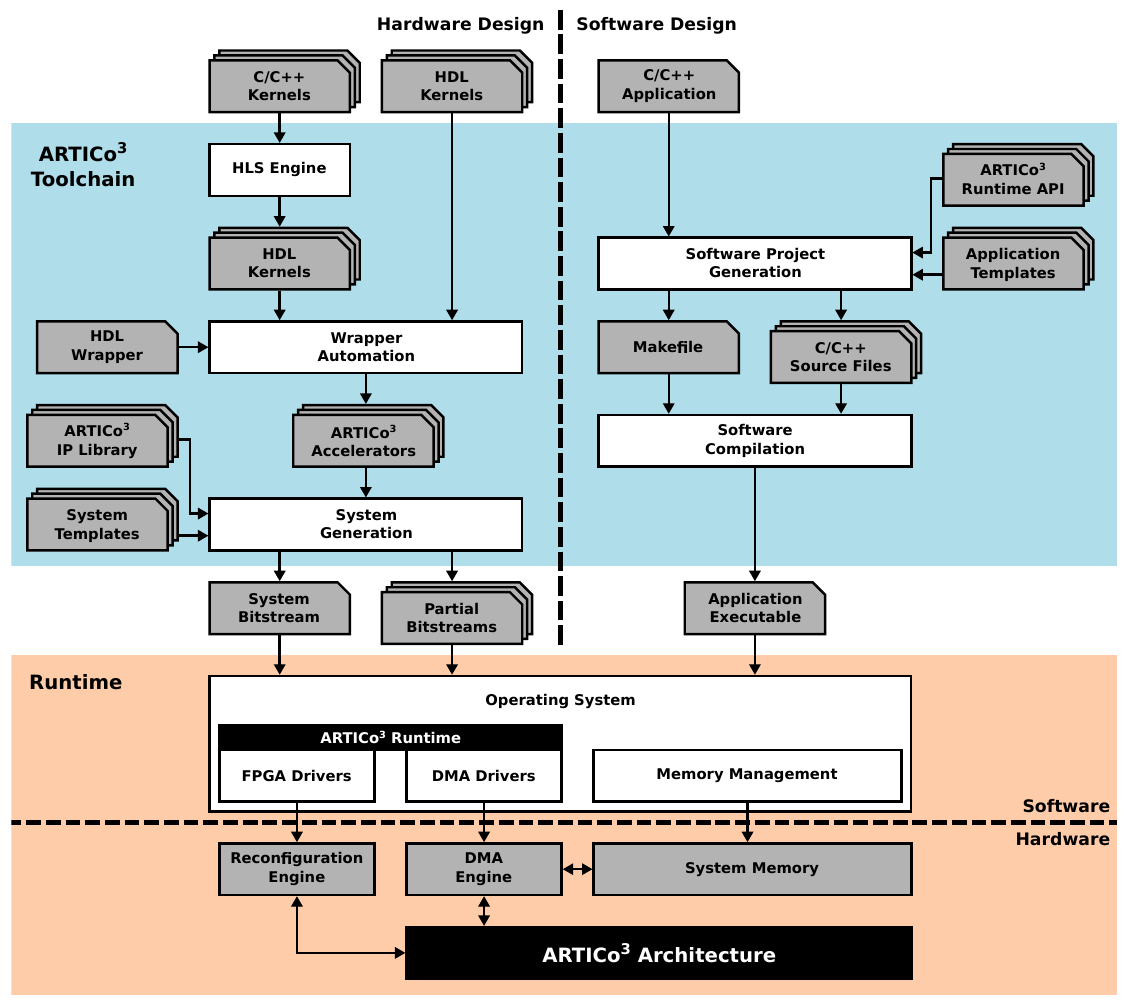
Figure 1. The ARTICo 3